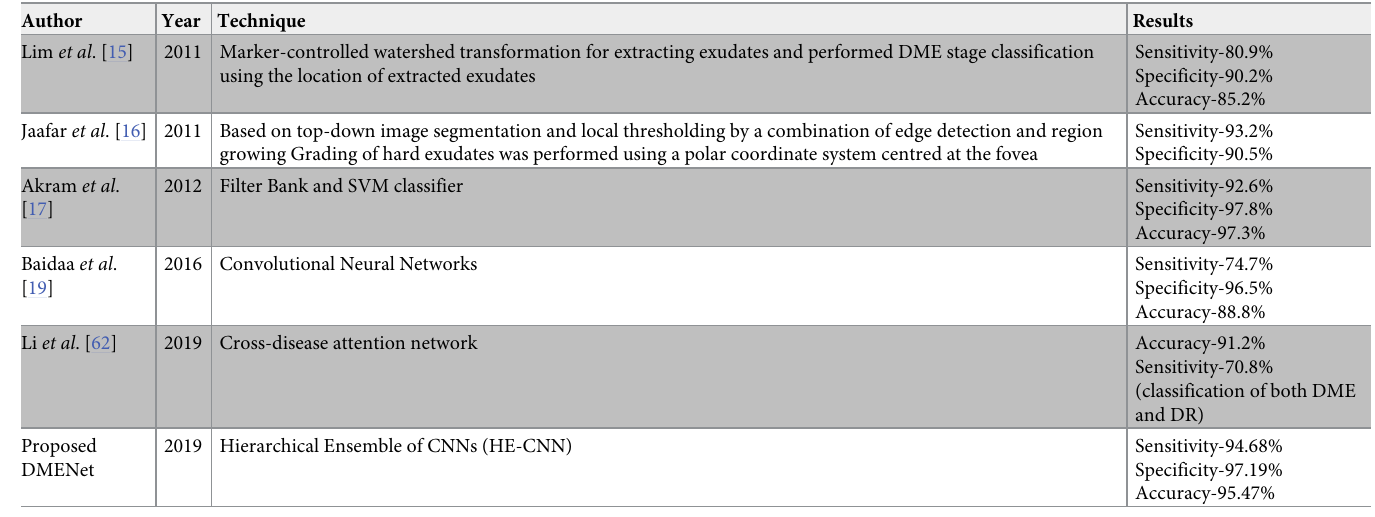
Table 5. Comparitive study of DMENet’s performance with recent solutions for DME screening using MESSIDOR dataset.